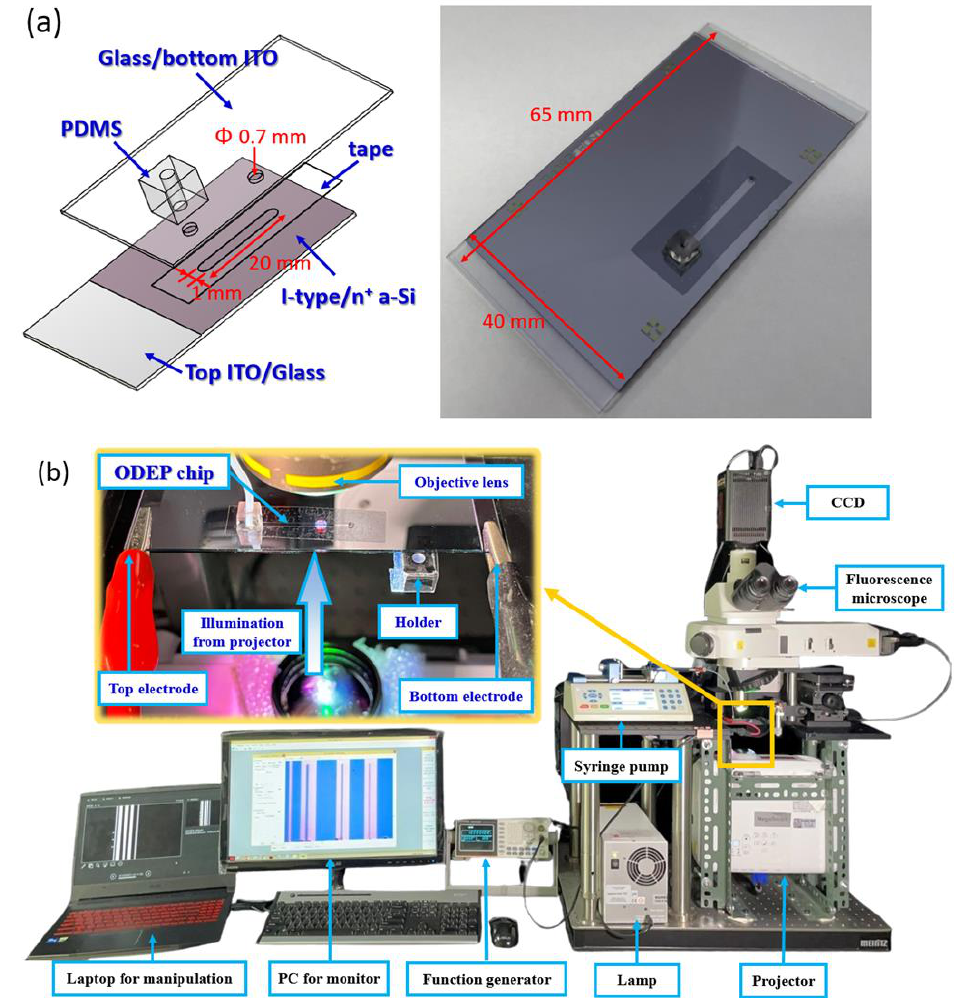
Figure 1. ( a ) Schematic plot and picture of the fabricated ODEP chip and ( b ) picture of the whole ODEP system setup.